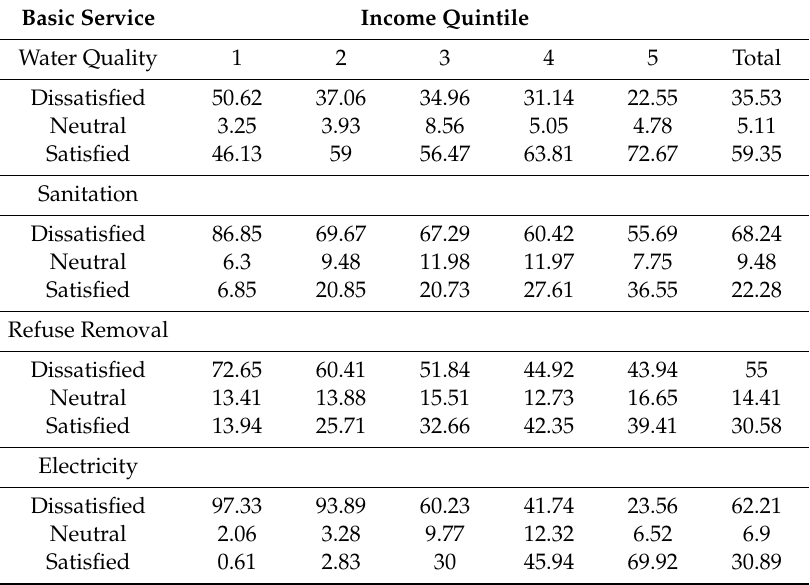
Table 3. Satisfaction with basic services by wealth quintile